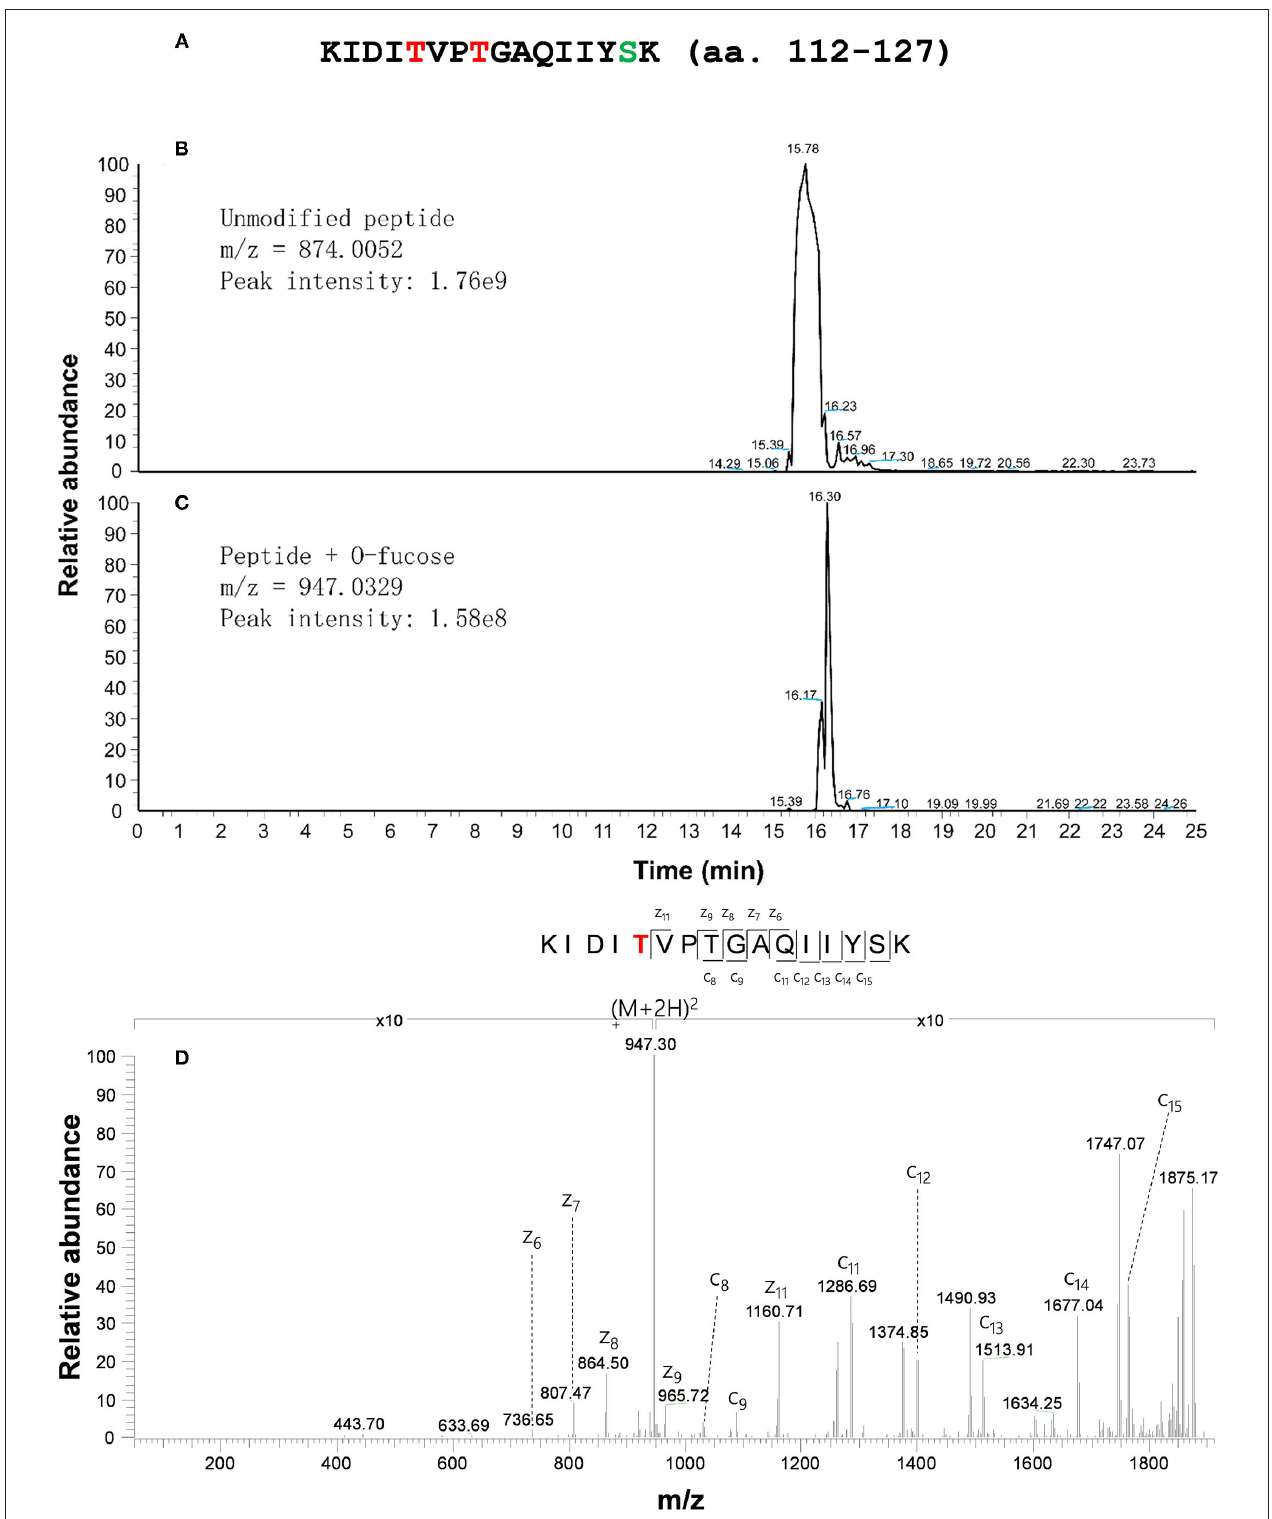
FIGURE 3 | CPN20 peptide is O -fucosylated in an in vitro SPY activity assay. (A) Amino acid sequence of synthesized CPN20 peptide (amino acid residues 112–127). The letters T in red and S in light blue indicate the residues mono- O -fucosylated. (B) EIC (Extracted ion chromatogram) of un- O -fucosylated CPN20 peptide. (C) EIC (Extracted ion chromatogram) of mono- O -fucosylated CPN20 peptide. (D) ETD MS2 spectrum of synthesized CPN20 peptide KIDIT O − fucose VPTGAQIIYSK. The CPN20 peptide reacted with GDP-fucose and 3TPR-SPY in the reaction buffer for 8h at 25 ◦ C before being analyzed by ETD-MS/MS.